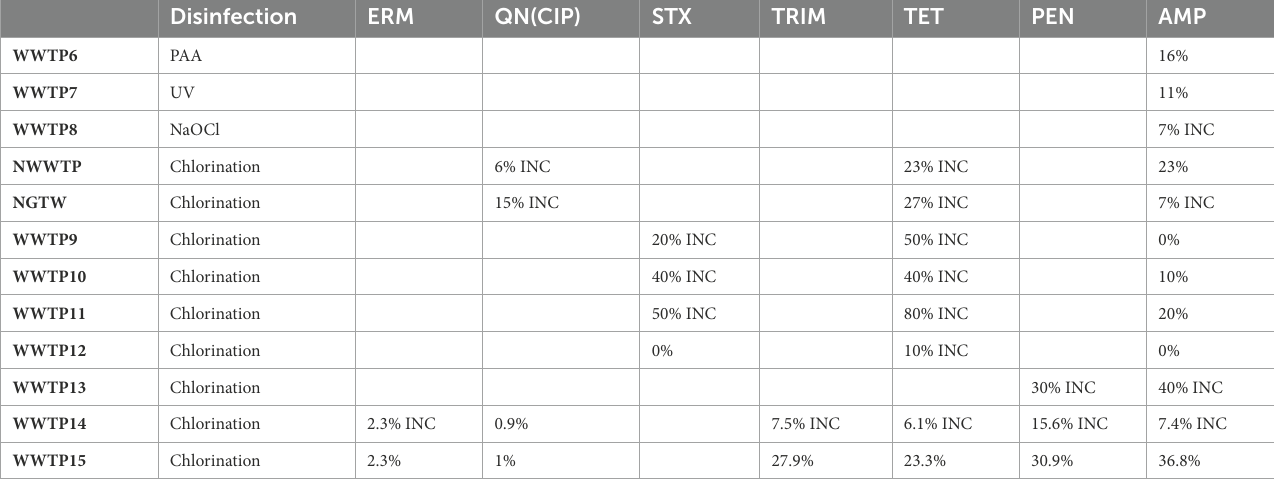
TABLE 4 Reduction of the percentage resistance of bacteria to